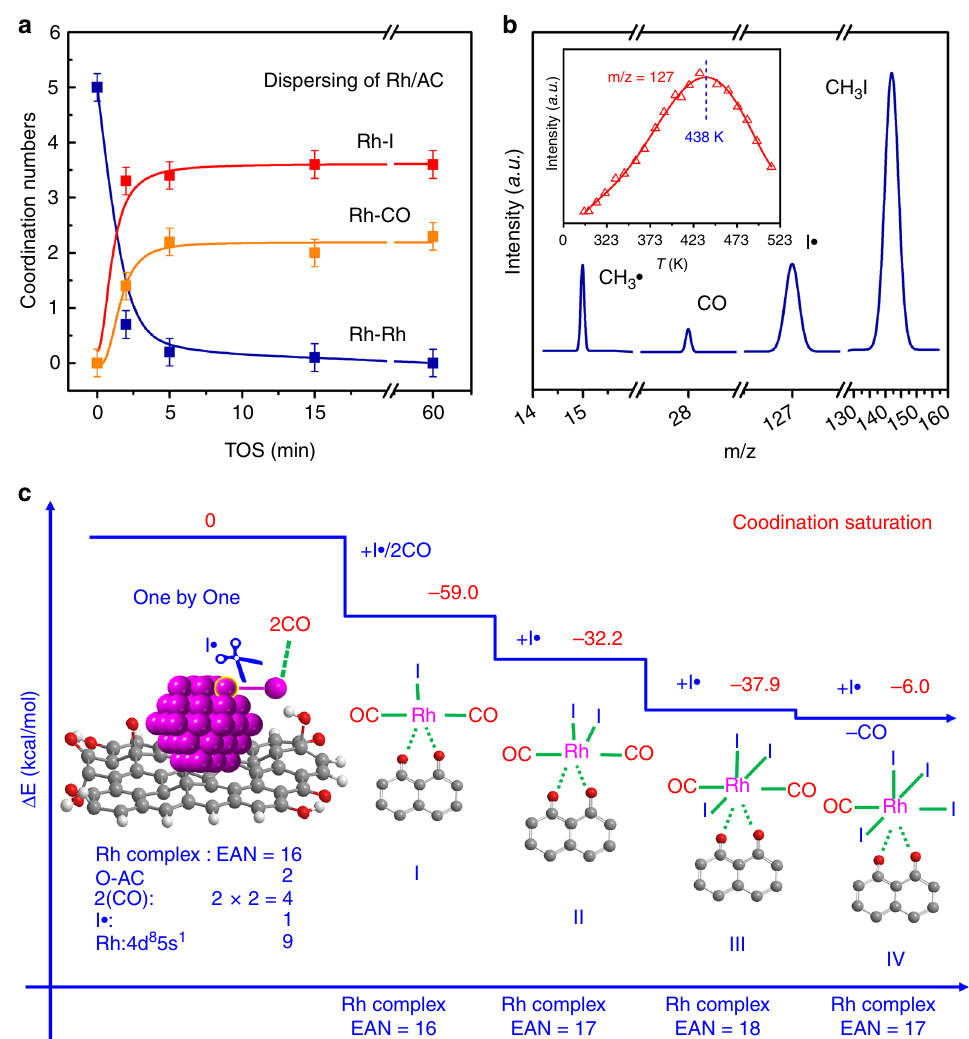
Fig. 3 Structure and model for the atomically dispersive process of Rh NPs. a Coordination number variation of Rh – Rh, Rh – I, and Rh – CO during atomically dispersion process derived from EXAFS result (Supplementary Table 4) of Rh/AC treated with CO/CH 3 I at 513 K for different time. b The representative mass spectra of different reactant and radical species detected during the in-situ reaction between Rh/AC and CO/CH 3 I at 513 K by LDI/TOF-MS. The inset is the variation of iodine radicals (I (cid:129) ) signals during the reaction between Rh/AC and CO/CH 3 I at different temperature. c The atomic dispersion model of Rh NPs via one-by-one mechanism based on the 16 – 18 effective atomic number (EAN)